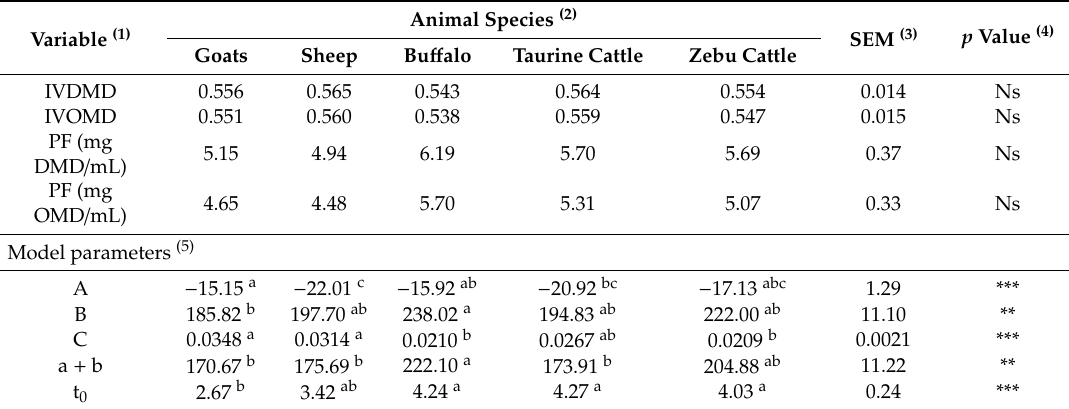
Table 4. E ff ect of animal species on degradability, fermentability and microbial e ffi ciency assayed in four forages during in vitro rumen